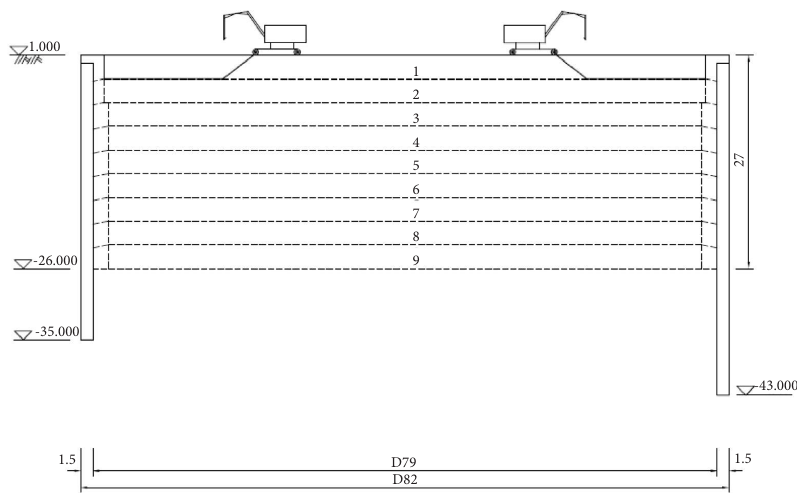
Figure 3: Elevation view of the foundation pit excavation layers.